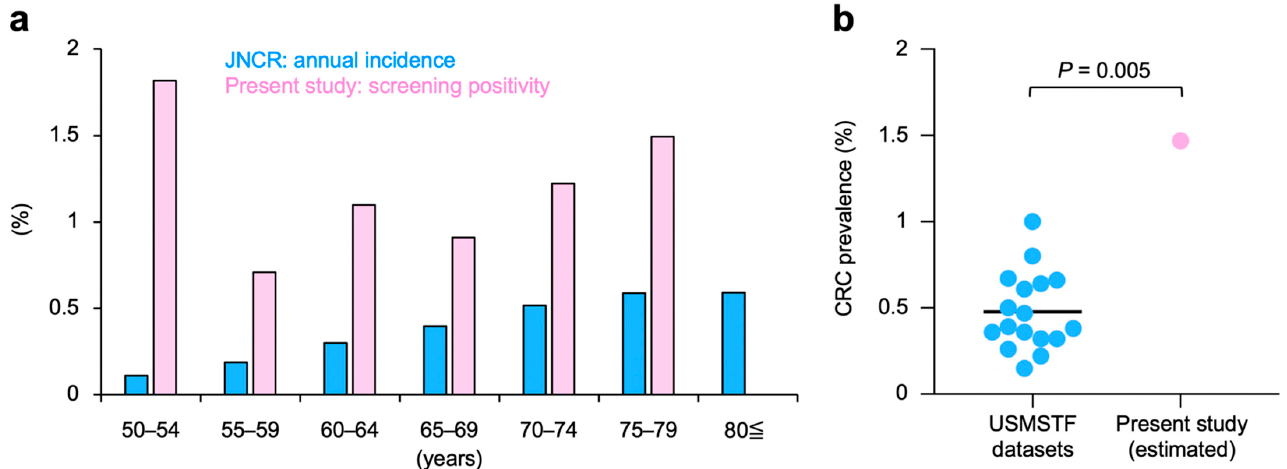
Figure 3. Comparison of colorectal cancer (CRC) screening outcomes between this study cohort and ( a ) the Japan National Cancer Registry (JNCR) or ( b ) a series of large-scale CRC screening studies reported in the U.S. Multi-Society Task Force (USMSTF) consensus statement. The details of the JNCR and USMSTF datasets are summarized in Section 2.1. p -values were assessed using the Smirnov–Grubbs test.